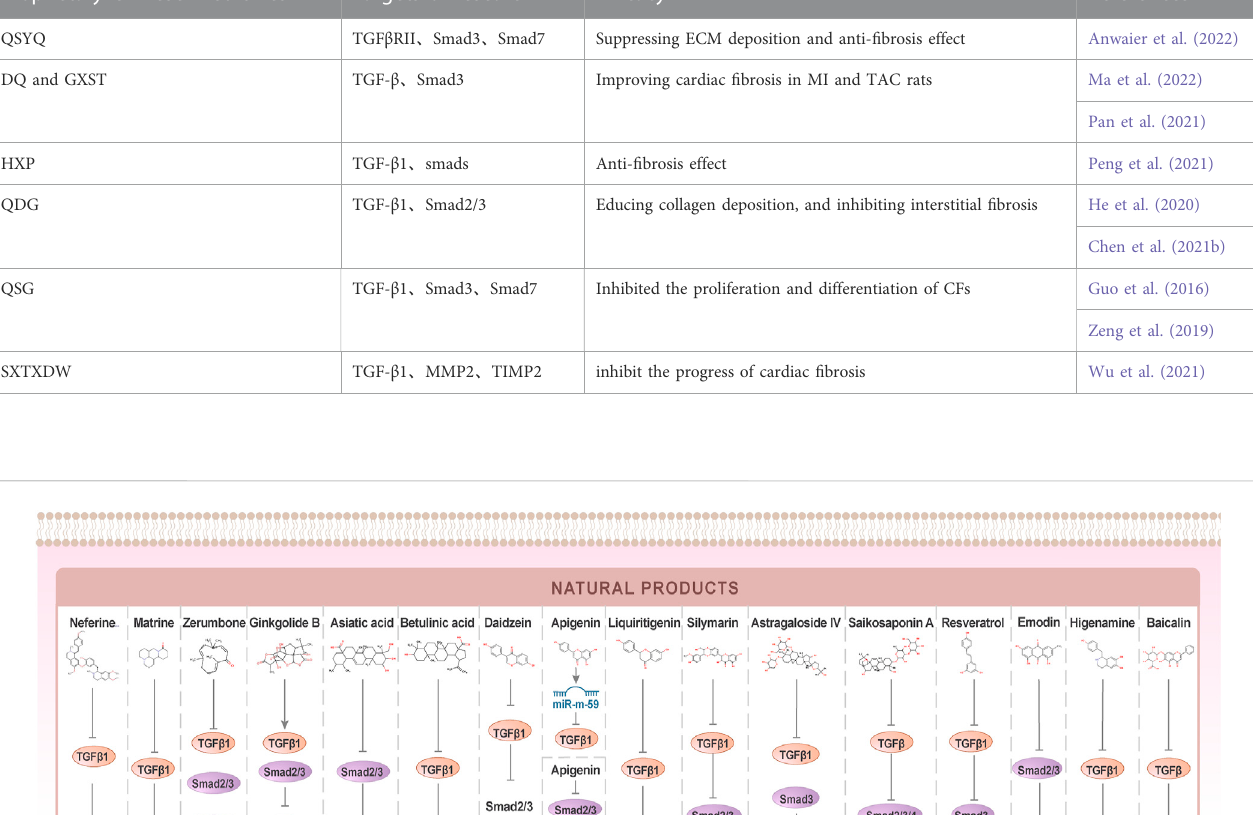
TABLE 6 Proprietary Chinese medicines regulating TGF-signaling pathway and intervening cardiac fi brosis. Proprietary Chinese medicines